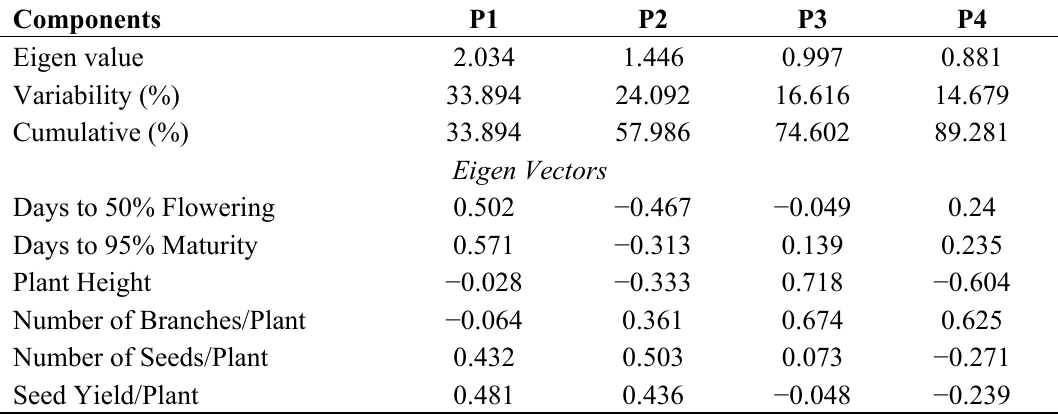
Table 3. Eigen values, individual and cumulative percentage variations and eigen vectors explained by four principal components based on morphological traits in 35 lentil genotypes. Components